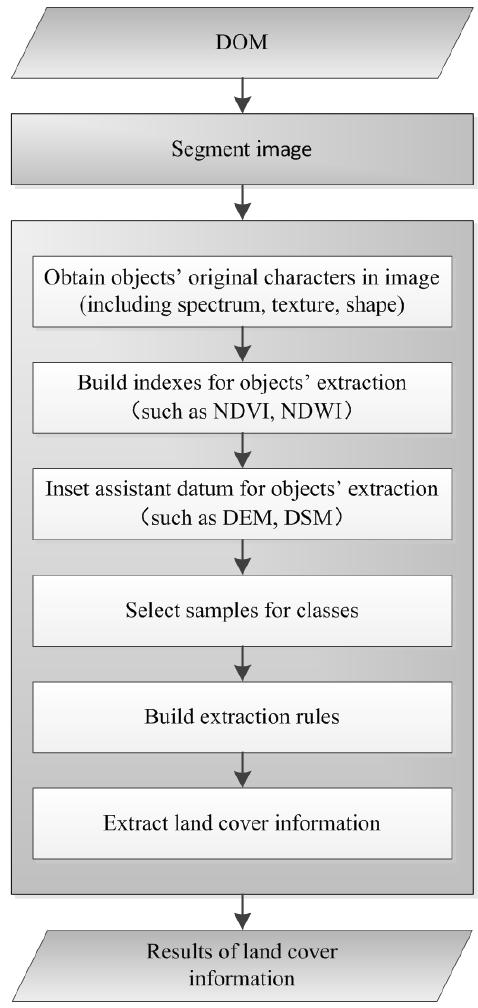
Figure 2. Work flow of automatic classification by